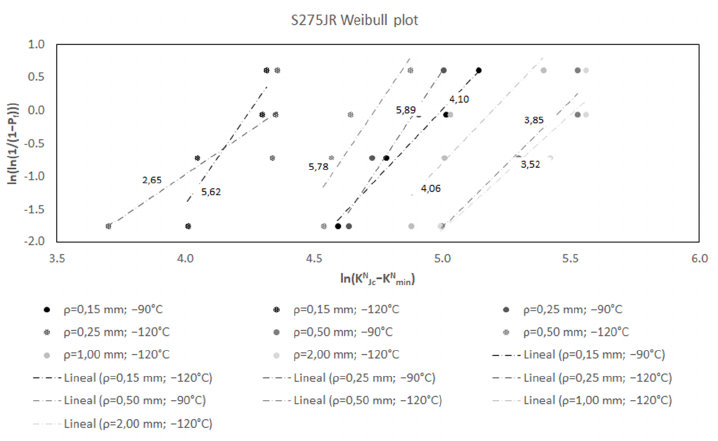
Figure 2. Statistical distribution of K NJc values determined from the three-parameter Weibull func- tion for steel S355J2.